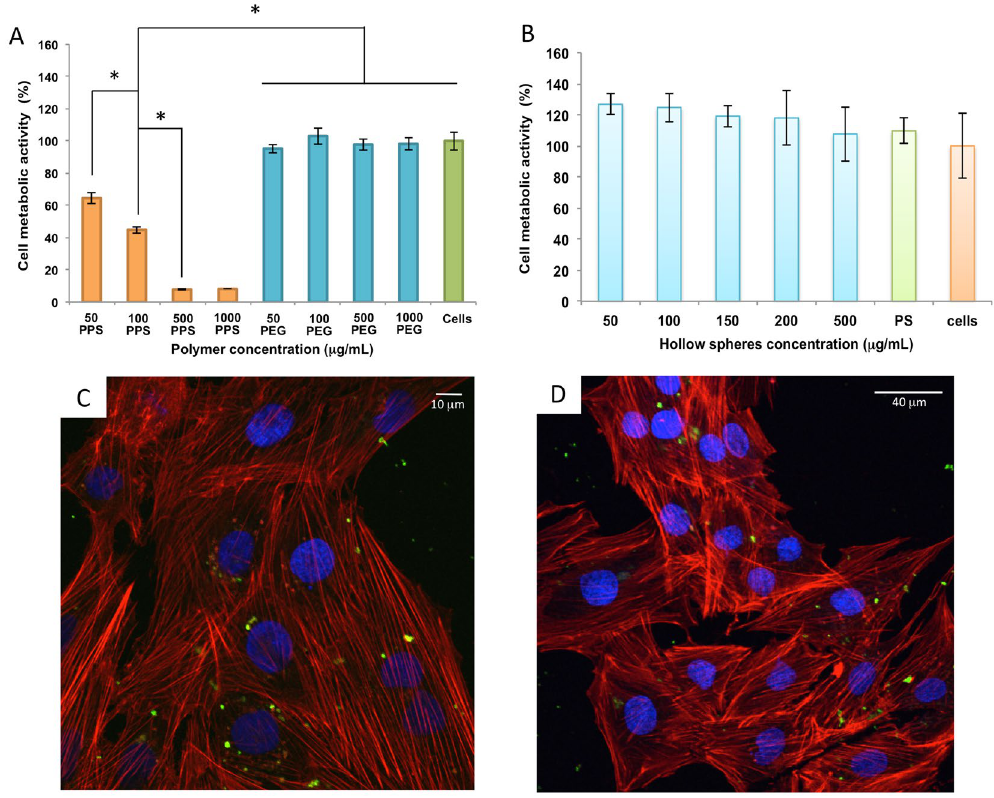
Figure 3. Cell metabolic activity on rat cardiomyoblasts H9C2 cells, after 24 hours and confocal imaging after microspheres internalization. alamarBlue ® assay was carried out on: ( A ) the synthesized polypropylene sulfide (PPS) in orange, PEG2000 (blue), untreated cells (green); ( B ) collagen-PPS hollow spheres (light blue), polystyrene (green) and untreated cells (orange) were used as controls (n = 3, p < 0.05). Confocal images of H9C2 rat cardiomyoblasts incubated for 24 hours with FITC-labeled collagen-PPS hollow spheres (green) at 50 μ g/mL ( C ); and 100 μ g/mL ( D ). Nuclei were stained with DAPI (blue), while actin fibers were stained with rhodamine phalloidin